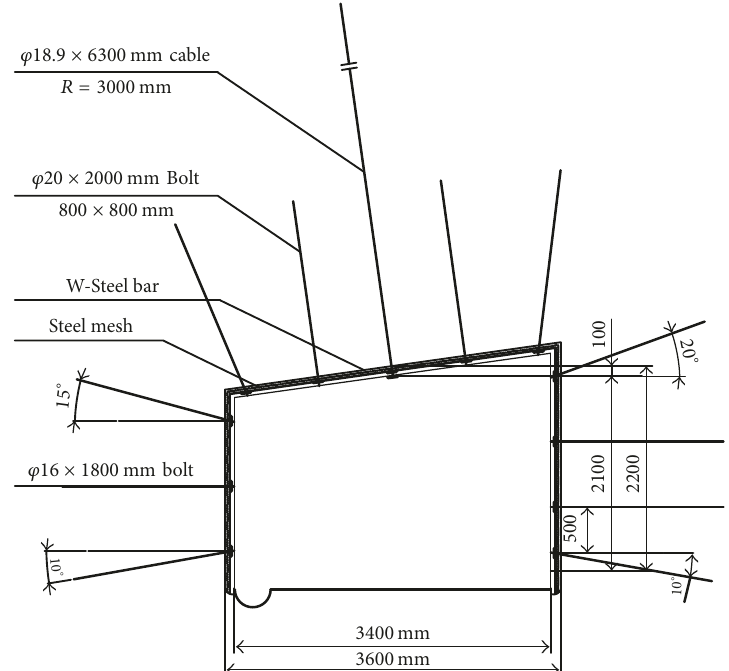
Figure 3: Cross section of support for tailgate.